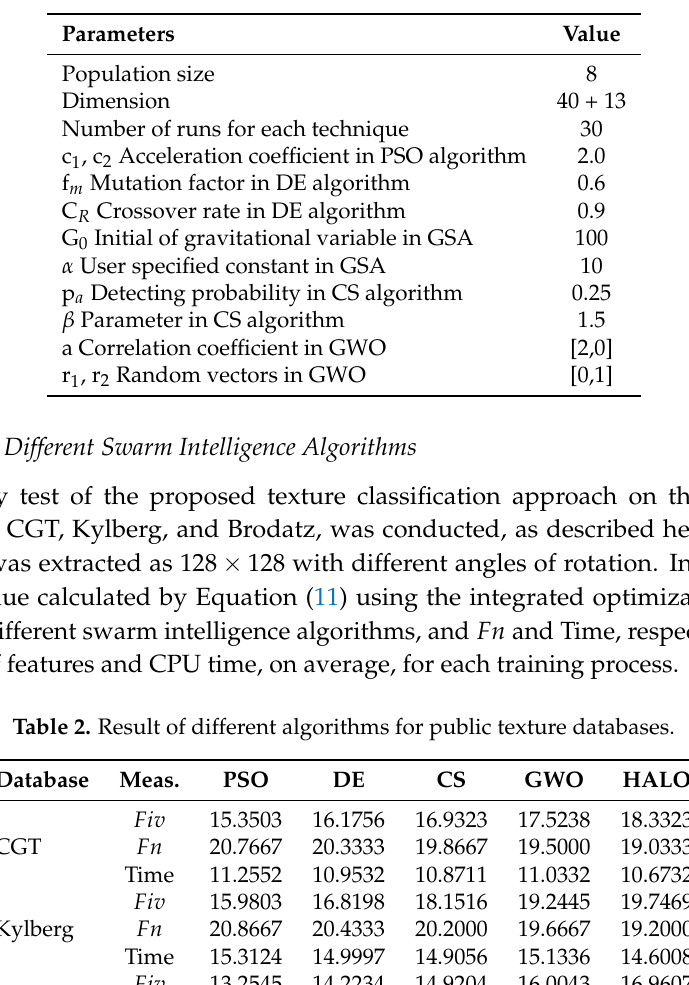
Table 1. Parameter settings for different algorithms.